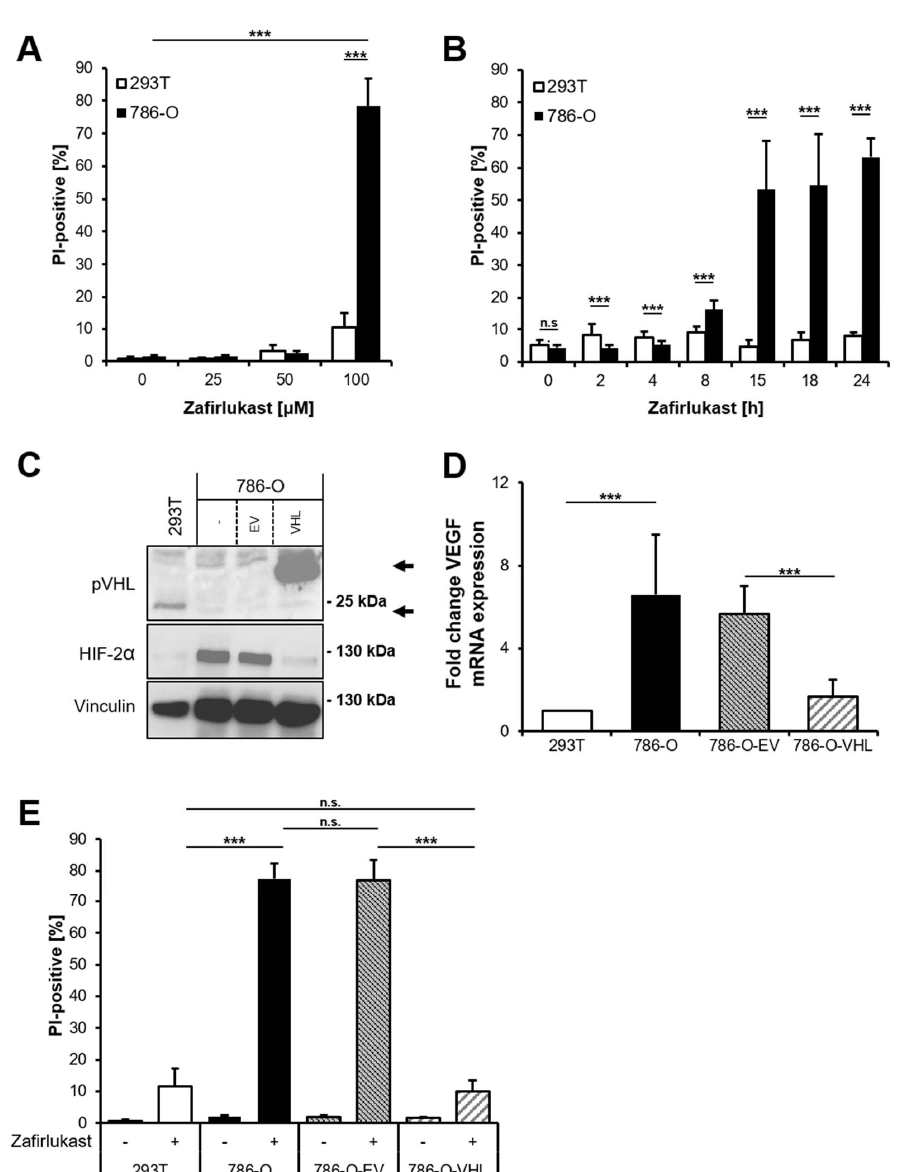
Figure 1. Zafirlukast triggers pVHL-dependent cell death. ( A ) 786-O and 293T cells were treated with the indicated concentrations of zafirlukast for 24 h, after which cell death was determined by quantifying PI uptake. Data are presented as percentage of PI-positive cells and mean and SD of three independent experiments performed in triplicate are shown. *** p < 0.001; ( B ) As in ( A ), but cells were exposed to 100 µM zafirlukast for the indicated time points. *** p < 0.001, n.s.: non-significant; ( C ) Western blot analysis of pVHL and HIF-2α expression in 293T, 786-O, 786-O-EV and 786-O-VHL cells. Vinculin served as loading control. Representative blots of at least three different independent experiments are shown. Lower arrow indicates endogenous pVHL, upper arrow indicates Flag-tagged reconstituted pVHL; ( D ) mRNA expression levels of VEGF in the indicated cell lines were determined using qRT-PCR. Data are normalized to GAPDH expression and are presented as x-fold mRNA expression compared to control. Mean and SD of three independent experiments performed in triplicate are shown. *** p < 0.001; ( E ) 293T, 786-O, 786-O-EV and 786-O-VHL were treated with DMSO or 100 µM zafirlukast for 24 h, after which cell death was determined by quantifying PI uptake. Data are presented as percentage of PI-positive cells and mean and SD of three independent experiments performed in triplicate are shown. *** p < 0.001, n.s.: non-significant.